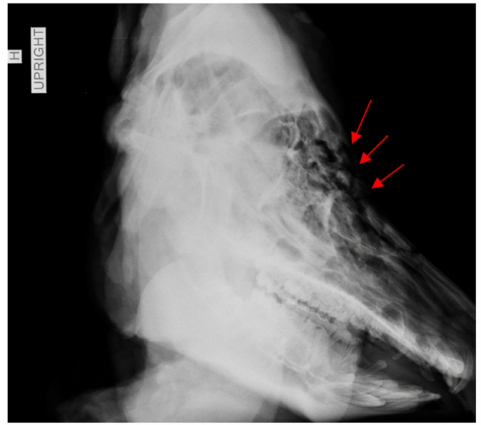
Figure 4. Radiographic image of specimen HH1. Red arrows point to areas of inwardly crushed bone, with displaced